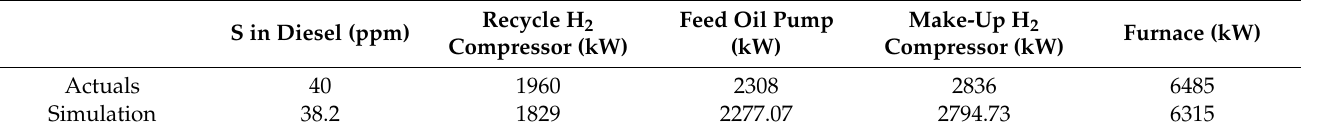
Table 4. Comparisons of utility